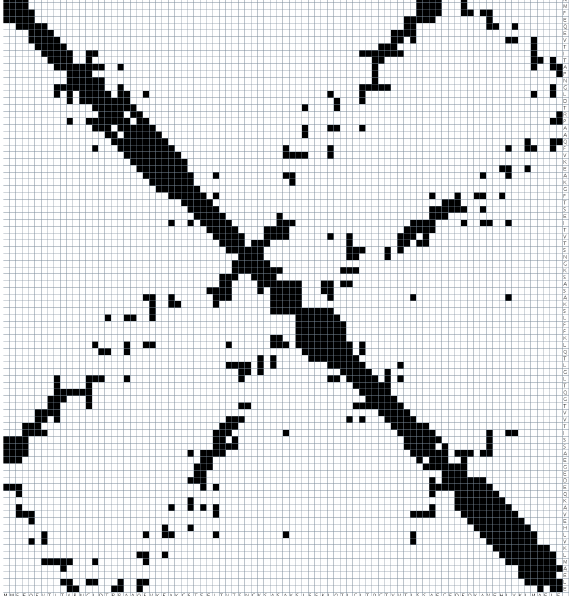
Figure 11: Predicted contact map for the protein 3CCD with a cut-off of 8